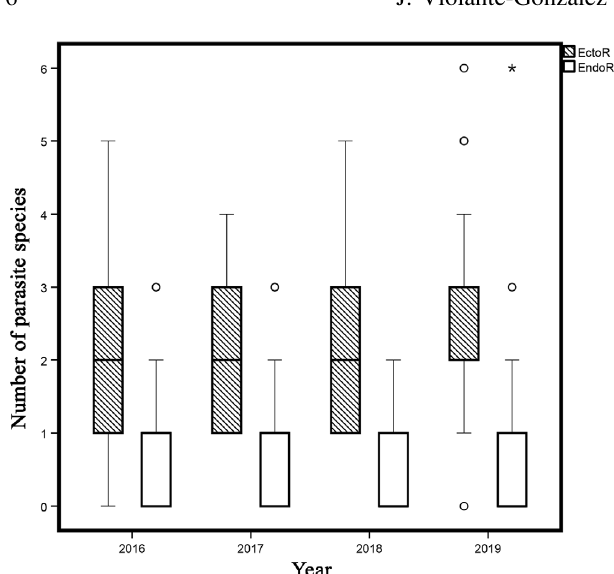
Figure 1. Box plot of species number of ectoparasites (monogenean and crustacean), and endoparasites (larvae and adults) in Caranx sexfasciatus from Acapulco Bay. The bottom and top of the boxes represent the lower and upper quartiles respectively; the median is shown as a line through the centre of the boxes; outliers are indicated with circles for ectoparasites and asterisks for